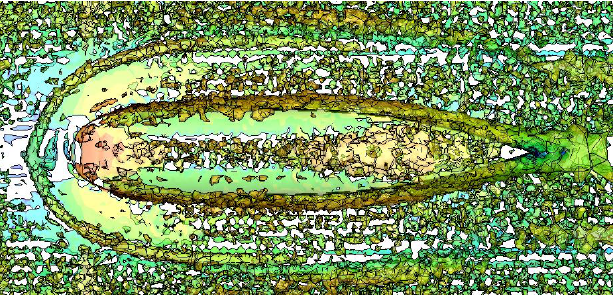
Figure 187. The diagram of the horseshoe vortex near the sail hull. Figure 17. The diagram of the horseshoe vortex near the sail